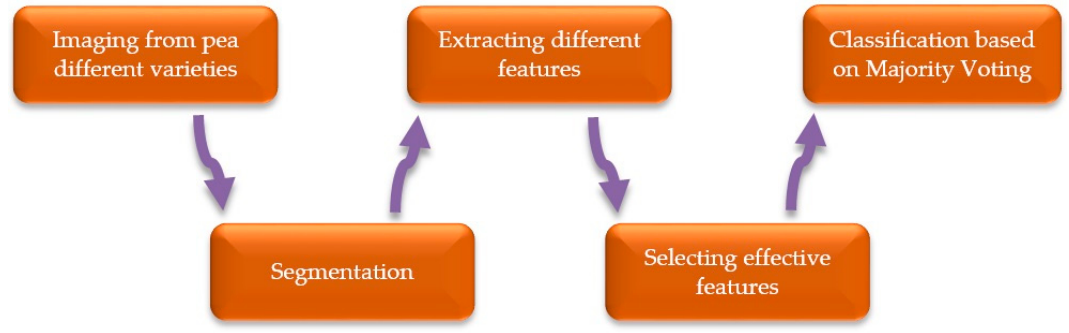
ff erent chickpea ( Cicer arietinum L.)